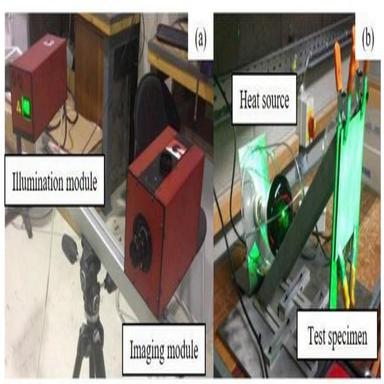
(a) Laser shearography NDI system and (b) test specimen and clamp used.